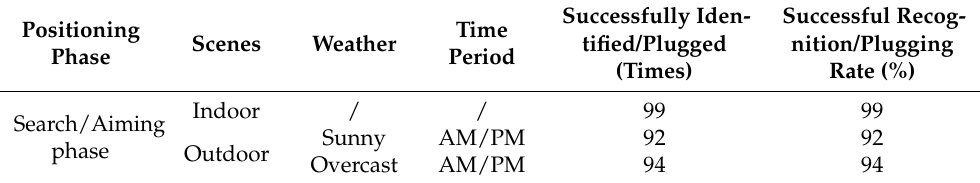
Table 6. Results of the plug-in experiment.